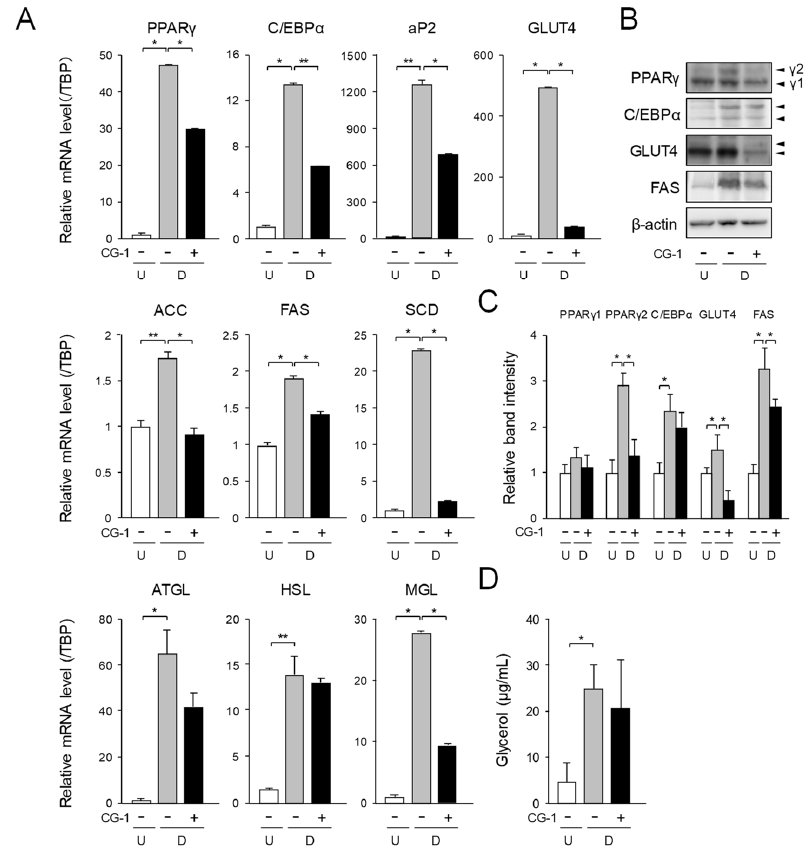
Figure 3. Suppression of adipogenesis by CG-1 in 3T3-L1 cells. ( A ) Transcription levels of the adipogenesis-related genes in CG-1-treated 3T3-L1 cells. The cells (undi ff erentiated cells: U; white columns ) were di ff erentiated ( D ) into adipocytes for 6 days in DMEM without ( gray columns ) or with CG-1 (10 µ M; black columns ). Results are presented as the means ± S.D. from three experiments. * p < 0.01, ** p < 0.05, as indicated by the brackets. ( B ) Change in the protein levels in 3T3-L1 cells. The cells were cultured as described in the legend of Figure 3A. Protein (15 µ g) was loaded in each lane. Data are representative of three experiments. β -actin was used as the internal control. γ 1 and γ 2 mean PPAR γ isoforms: PPAR γ 1 and PPAR γ 2, respectively. Data are representative of three experiments. ( C ) Band intensity of Western blot analysis. About C / EBP α and GLUT4, both of these two bands were measured and shown as the total in band intensity. Results are presented as the means ± S.D. * p < 0.01, as indicated by the brackets. ( D ) Glycerol release level in 3T3-L1 cells. The cells were di ff erentiated as described in the legend of Figure 3A. Data are the means ± S.D. from three experiments. * p < 0.01, as indicated by the